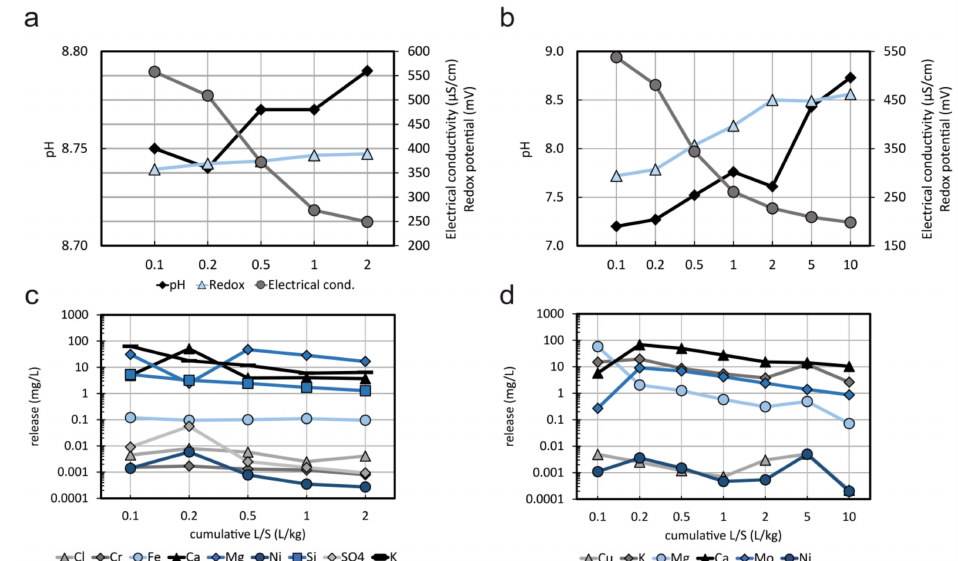
Figure 8. ( a ) pH, redox potential and electric conductivity during percolation test of sample C n ; ( b ) pH, redox potential and electric conductivity during percolation test of sample E; ( c ) concentrations of selected elements in individual fractions during percolation test of sample C n ; ( d ) concentrations of selected elements in individual fractions during percolation test of sample